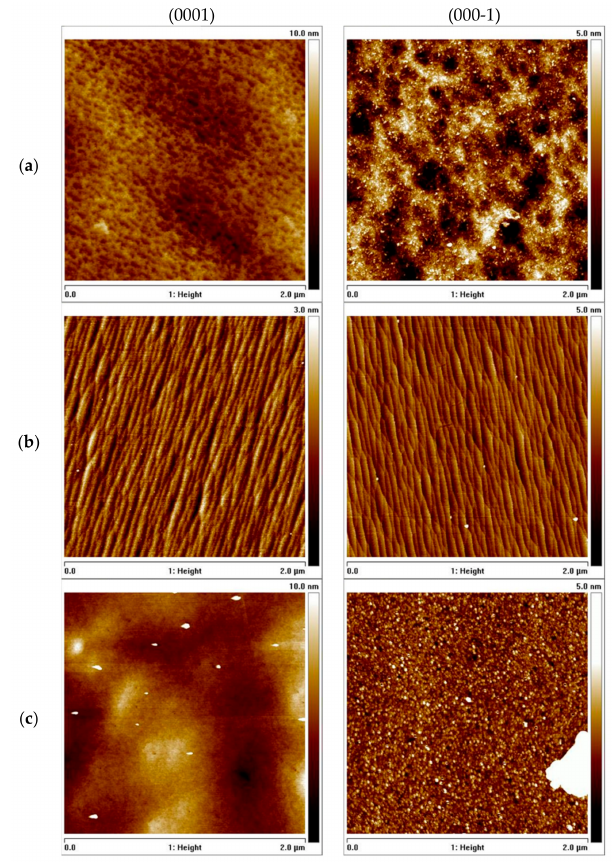
Figure 4. AFM images of the samples’ surfaces: (0001)—left column and (000-1)—right column, respectively, annealed in three configurations presented in Figure 2; annealing: ( a ) configuration A—only in N 2 ; ( b ) configuration B—covered by GaN powder; ( c ) configuration C—with Ga droplet close to the samples’